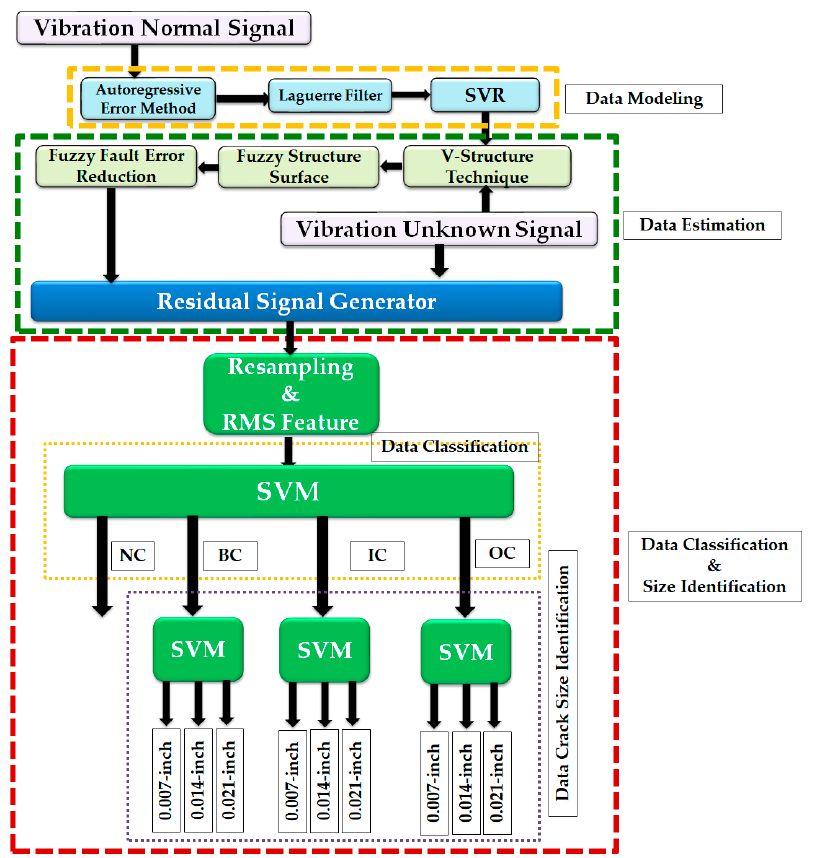
Figure 3. Bearing data classification and data crack size identification using the proposed improved fuzzy V-structure